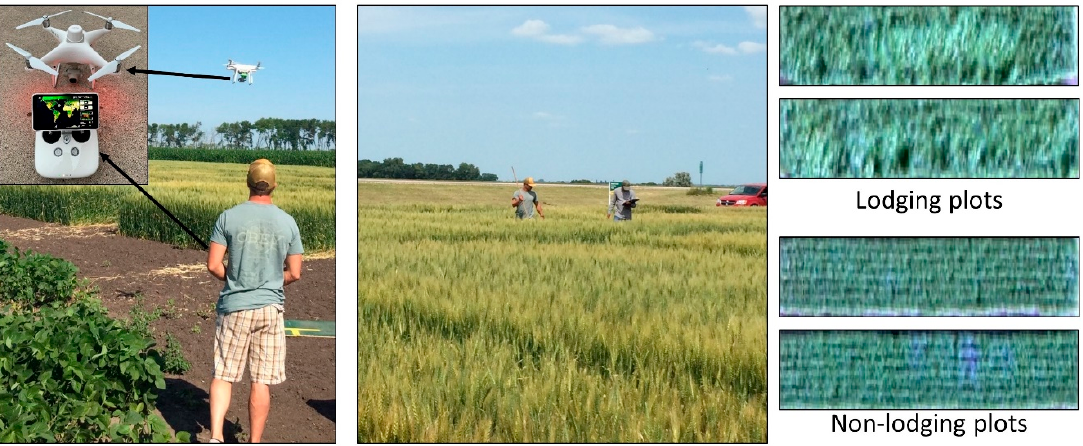
Figure 3. Field wheat lodging data collection: left, aerial imagery collection; middle, manual/visual evaluation of plot lodging or non-lodging; right, UAS image samples of lodging and non-lodging plots.